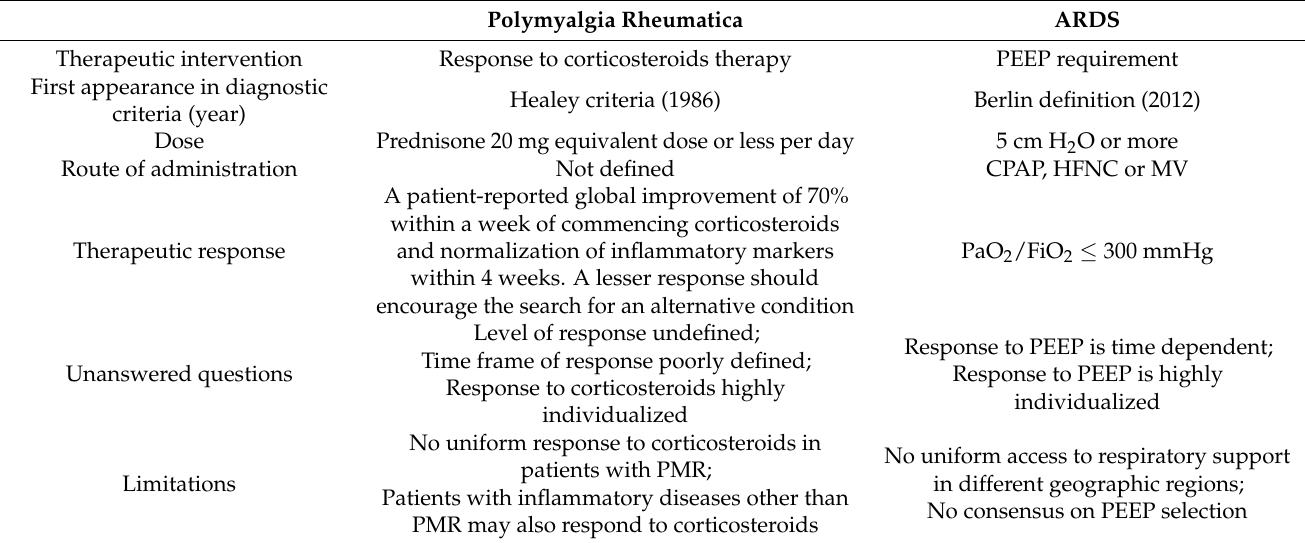
Table 2. Therapeutic interventions in diagnostic criteria: response to corticosteroid therapy in polymyalgia rheumatica versus PEEP requirement in